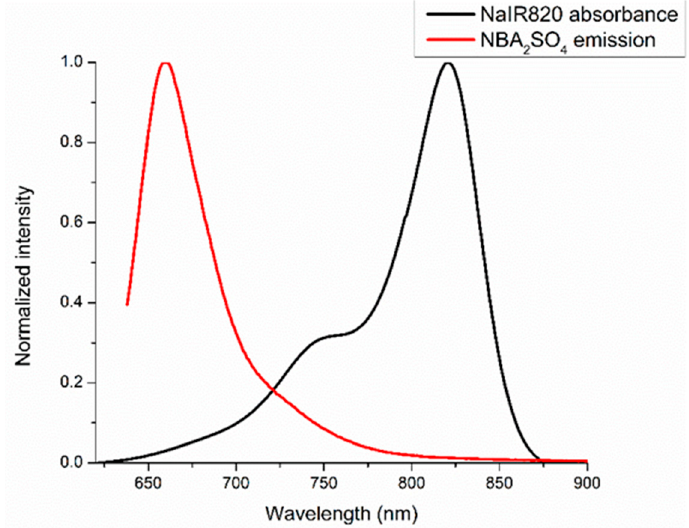
Figure 4. Normalized fluorescence emission spectra of NBA 2 SO 4 (donor) and absorption spectra of NaIR820 (acceptor) in ethanol.